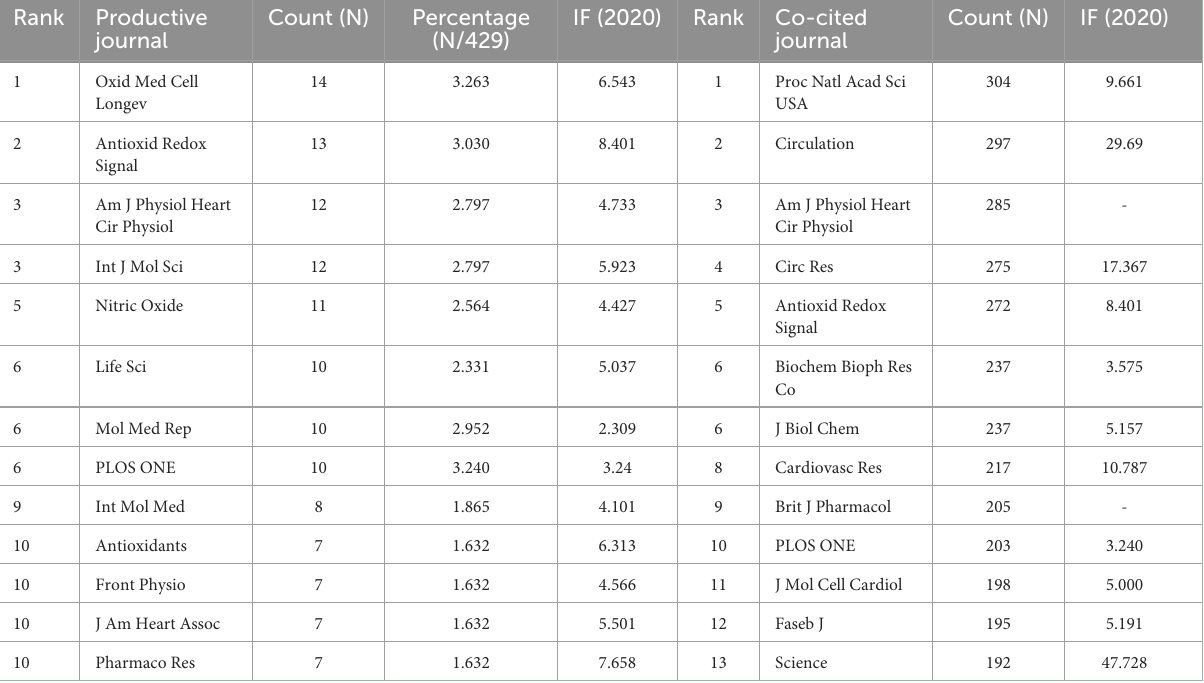
TABLE 2 Top 13 productive journals of hydrogen sulfide in heart preservation research.